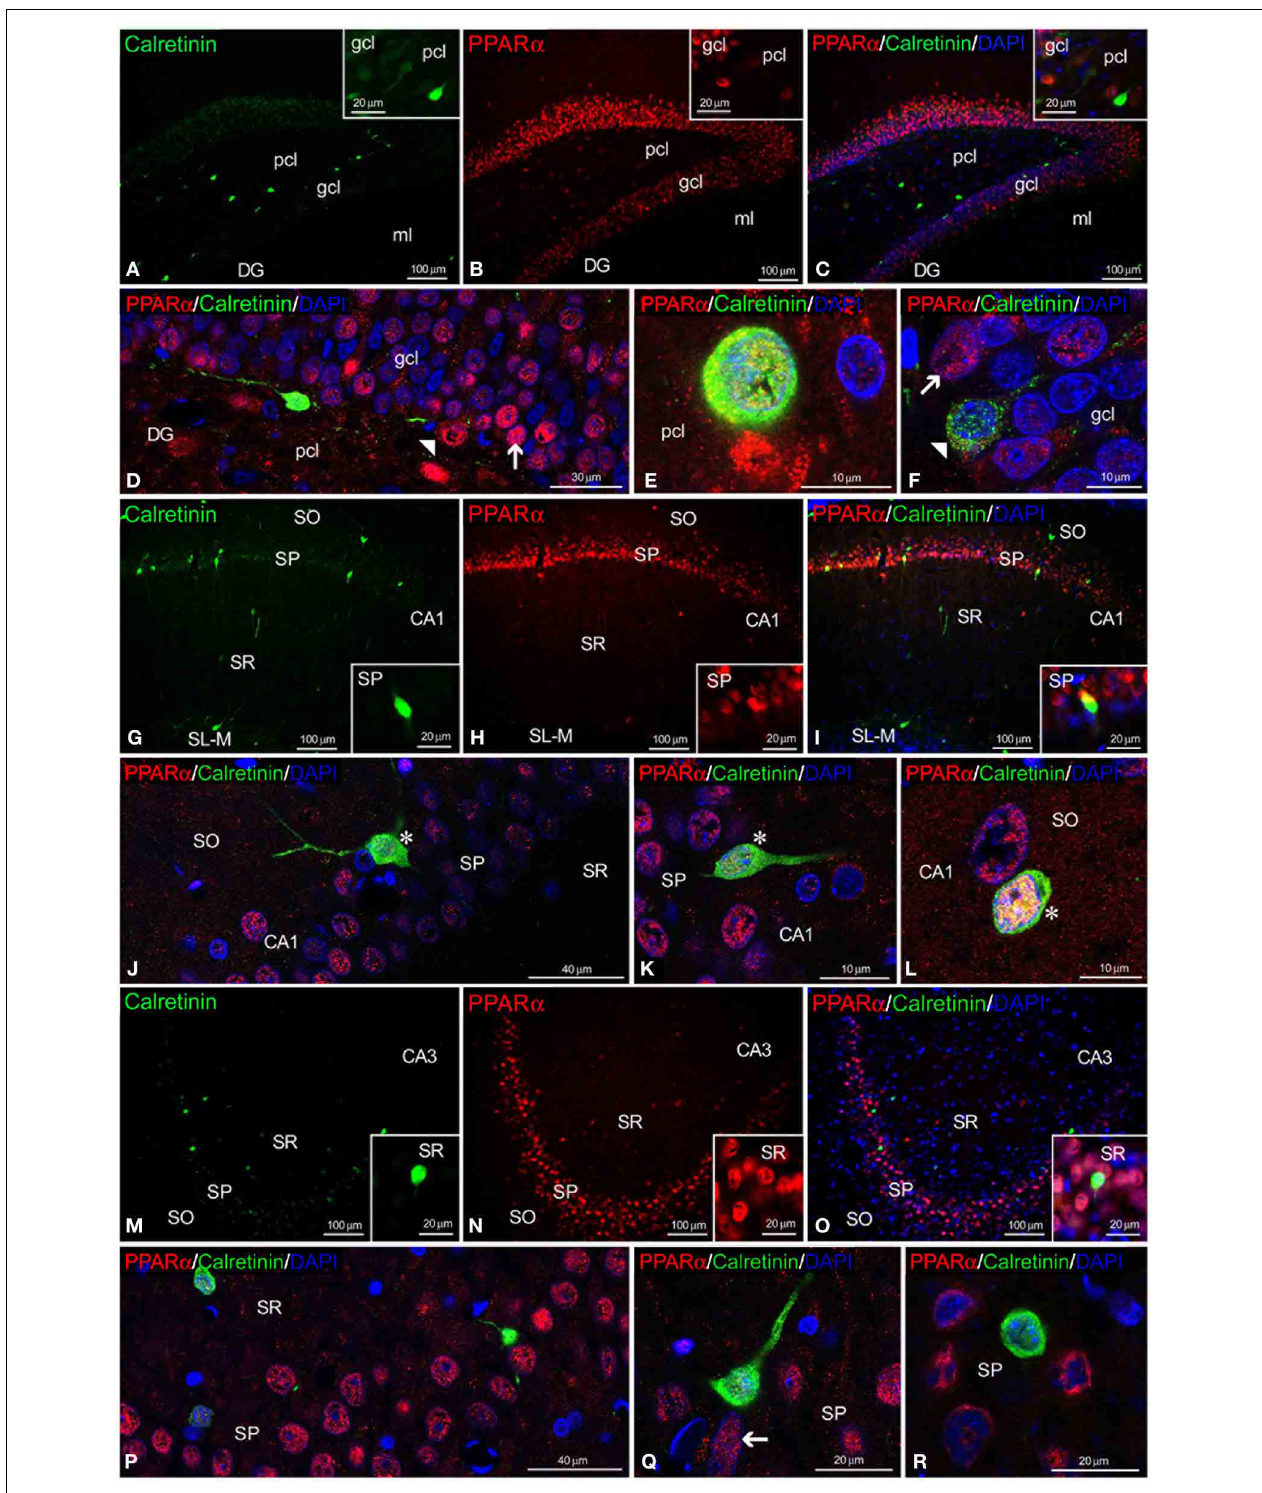
FIGURE 4 | PPAR α and calretinin co-expression in the rat hippocampus. Low-resolution epifluorescence photomicrographs (A–C,G–I,M–O) and high-resolution confocal laser scanning photomicrographs (D–F,J–L,P–R) showing the labeling of calretinin (green) and PPAR α (red) in the dentate gyrus (DG), CA1, and CA3 areas. DAPI